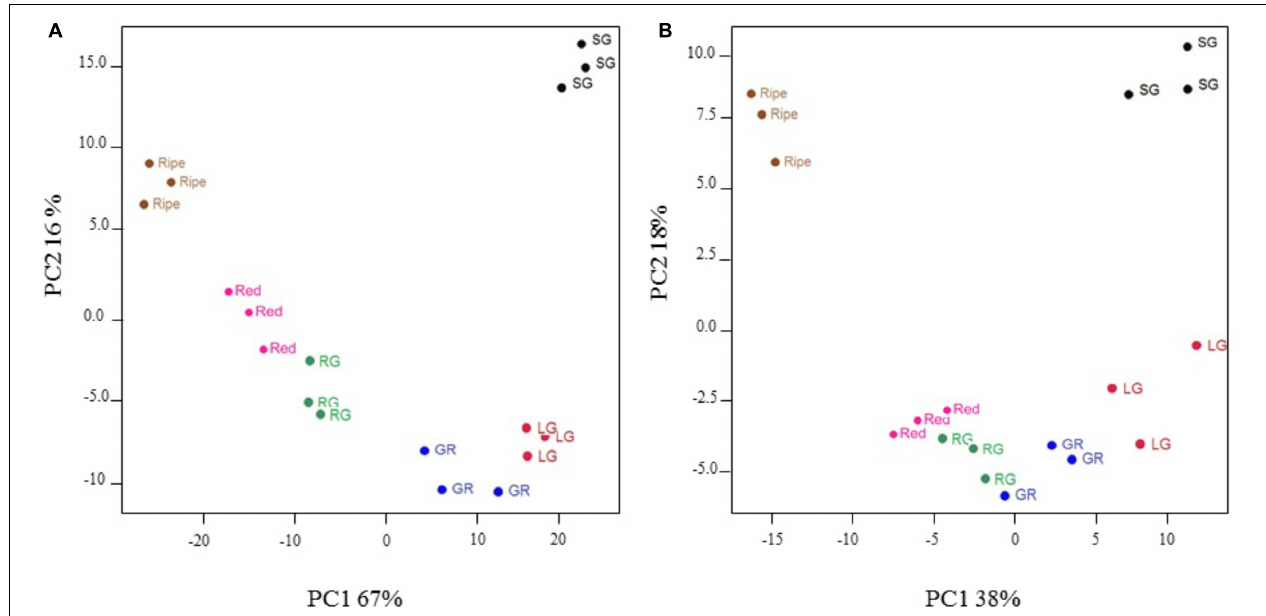
FIGURE 3 | Principal components analysis of significantly differentially expressed transcripts (A) and selected metabolites (B) in developing blackcurrant fruit. Fruit were collected from three individual plants at the small green (SG), large green (LG), green–red (GR), red–green (RG), red and ripe fruit stages.